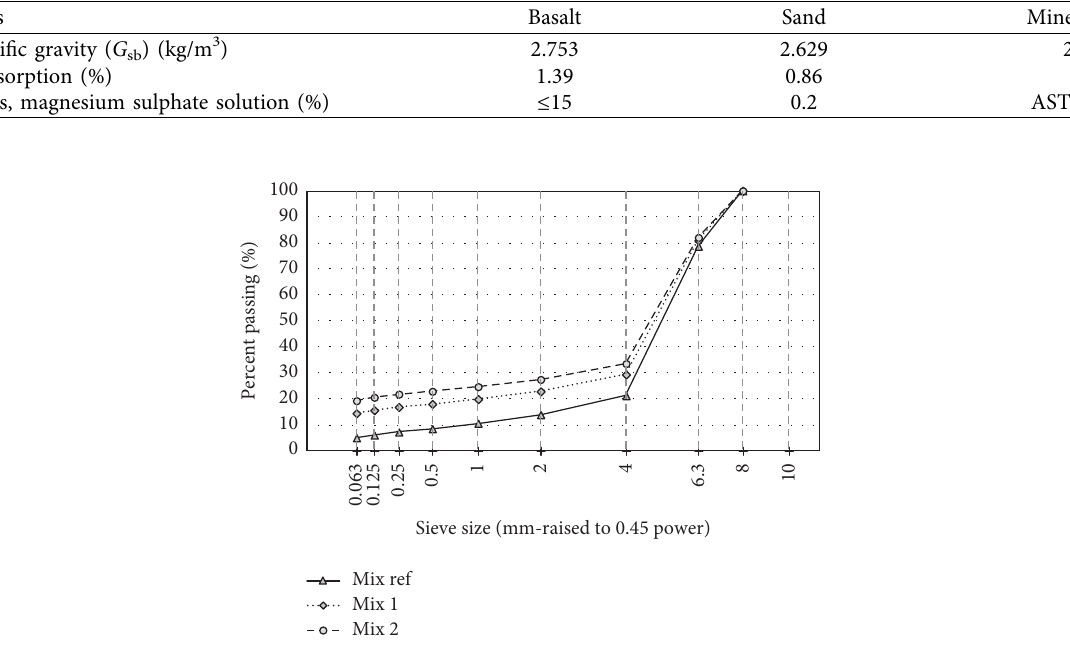
Figure 2: Aggregate gradations of mix ref, Mix 1, and Mix 2.